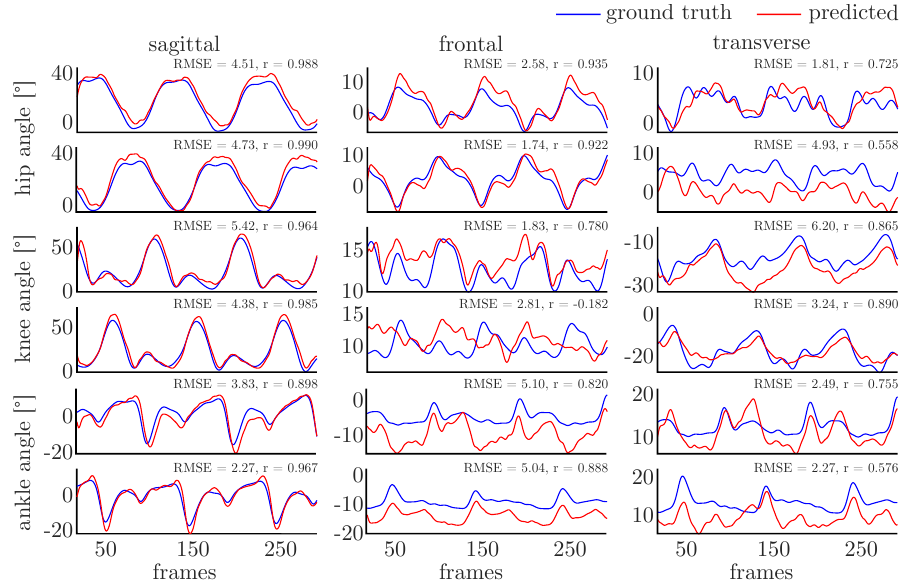
Figure 6. A single example of the joint angle prediction using PCA-net . The joint angles predicted for the right are displayed on top of those predicted for the left. The sample depicts the one with the median RMSE value.